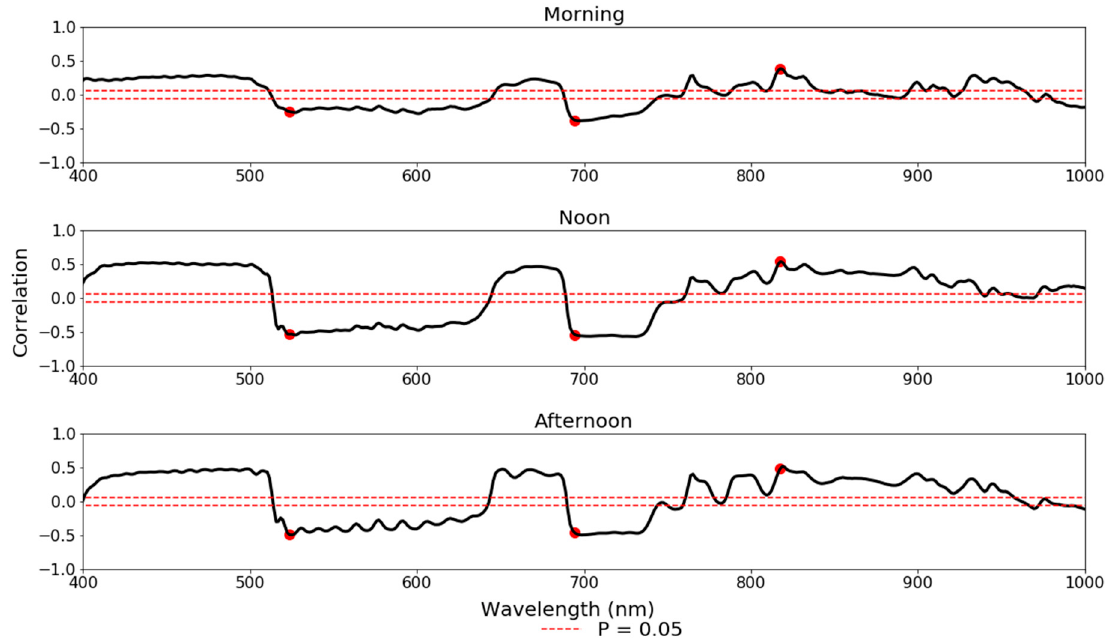
Figure 9. Correlation coe ffi cients between standard normal variate reflectance rates and transpiration rates during the morning (n = 2376), noon (n = 1970) and afternoon (n = 3271). Critical correlation value (confidence level) is marked with a red dashed line; selected maximum absolute correlation bands are marked with a red circle.